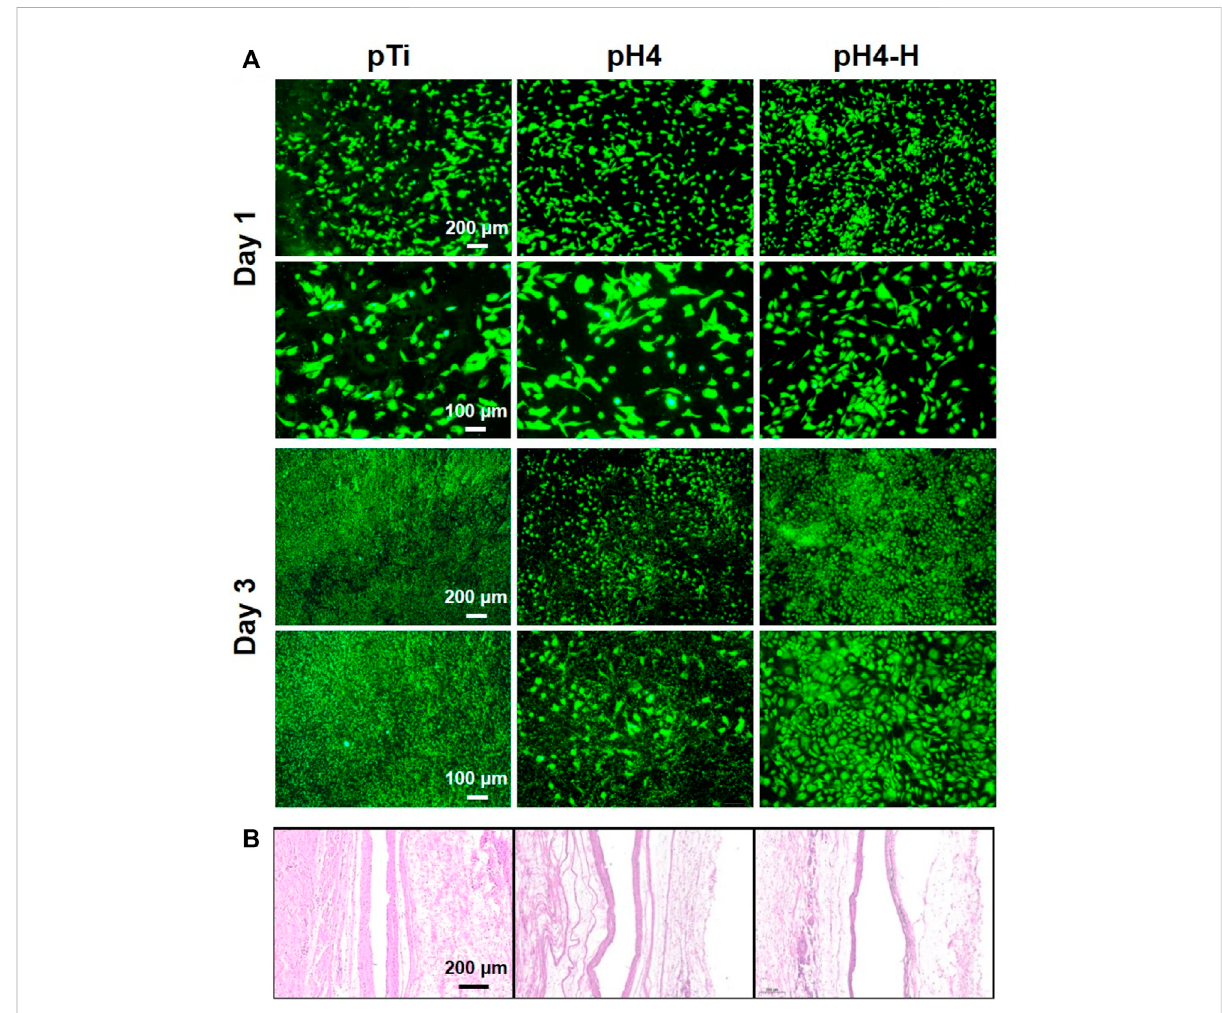
FIGURE 7 Co-culture of bacterial and cell or tissue: (A) Osteoblasts (MC3T3-E1) were seeded on different samples inoculated with S. aureus and cultured for 1 and 3 days; (B) HE staining about local tissue (pretreated with S.aureus) of various samples after 1 month of subcutaneous